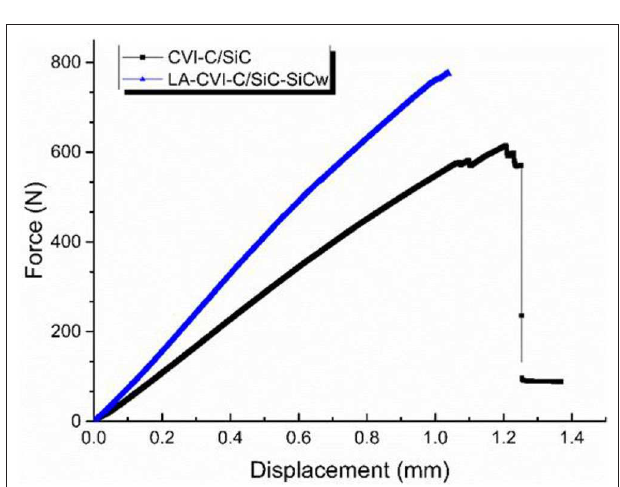
FIGURE 2 | Comparison of force–displacement curves for the two composites. C/SiC, continuous fiber-reinforced silicon carbide ceramic matrix; LA-CVI, laser-assisted chemical vapor infiltration; SiC, silicon carbide; SiCw, silicon carbide whiskers.